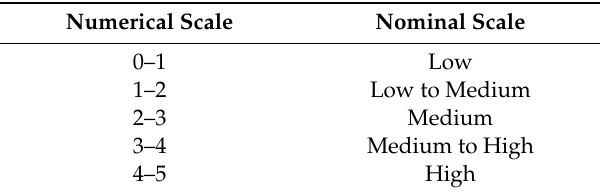
Table 1. Classification of normalized values.